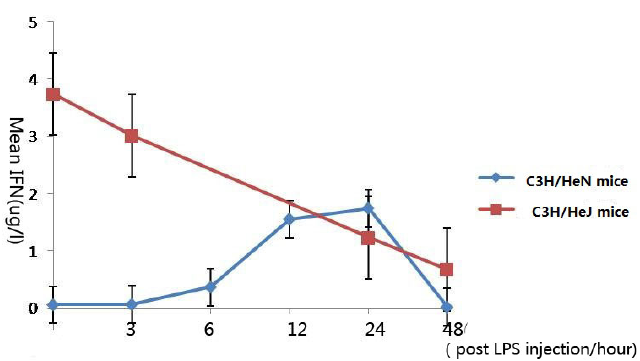
Figure 5. The expression levels of interferon- γ in the aqueous humor at different time points (expressed as the mean μ g/L ± SD). In C3H/HeN mice, IFN- γ reached a peak concentration 24 h after injection, and returned to its original concentration at 48 h. The peak concentration of IFN- γ of C3H/HeJ mice was the original concentration, and the concentration decreased with LPS